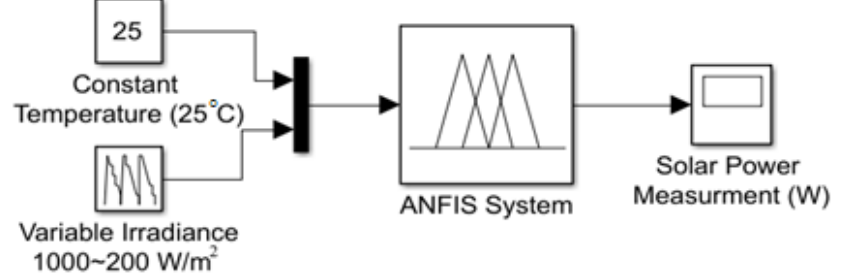
Figure 5. P solar ANFIS model.